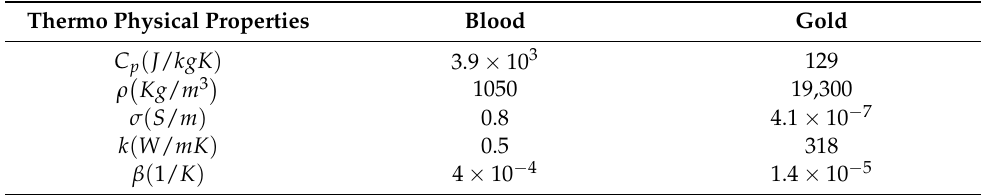
Table 1. Thermophysical properties of blood and gold nanoparticles (spherical shape).